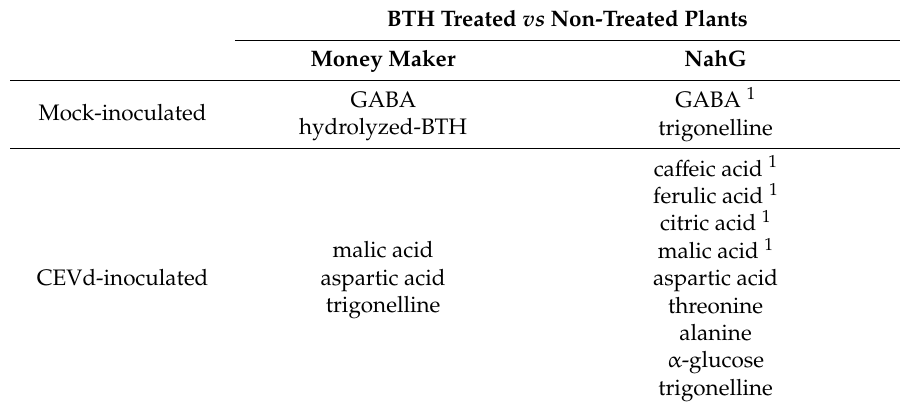
Table 1. Compounds significantly accumulated ( p -value ≤ 0.05) after BTH treatments in mock or CEVd-inoculated Money Maker and NahG tomato plants with respect to non-treated corresponding